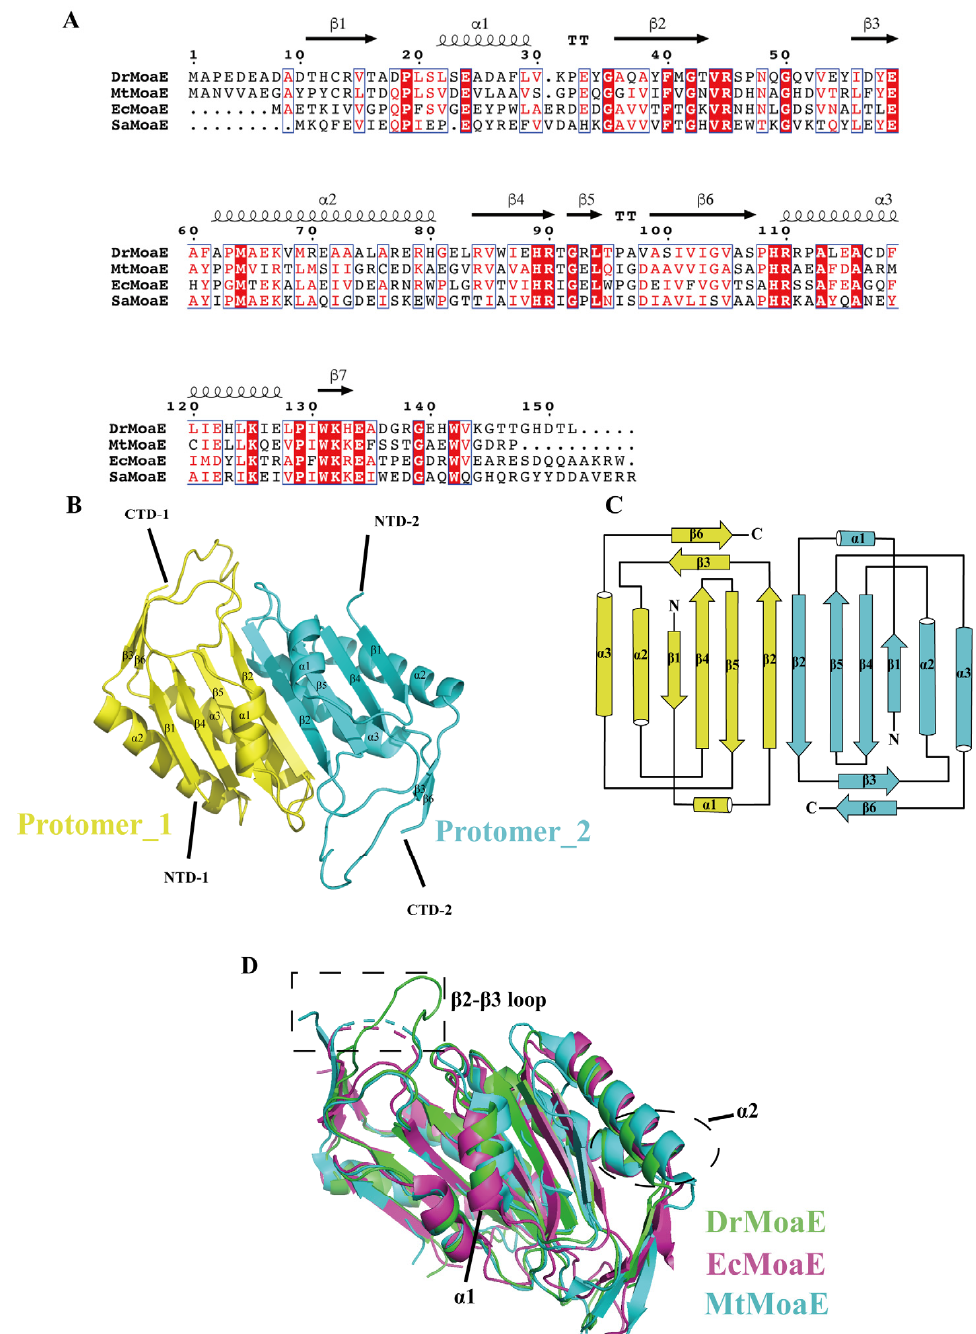
Figure 1. Overall structure of DrMoaE. ( A ) Sequence alignment of DrMoaE with homologous proteins of M. tuberculosis (MtMoaE), E. coli (EcMoaE), and S. aureus (SaMoaE). ( B ) The dimer of DrMoaE is shown as a cartoon and the two protomers are represented in yellow and blue, respectively. Each protomer’s α -helices, β -sheet, N-terminal (NTD), and C-terminal (CTD) are labeled. ( C ) Topology diagram of DrMoaE. The color is the same as in panel B. The N-terminal (N) and C-terminal (C) of each protomer are labeled. ( D ) Structural alignment of MoaE. D. radiodurans (green), E. coli (red), M. tuberculosis (blue). The dotted box indicates the loop between β 2 and β 3 sheets.